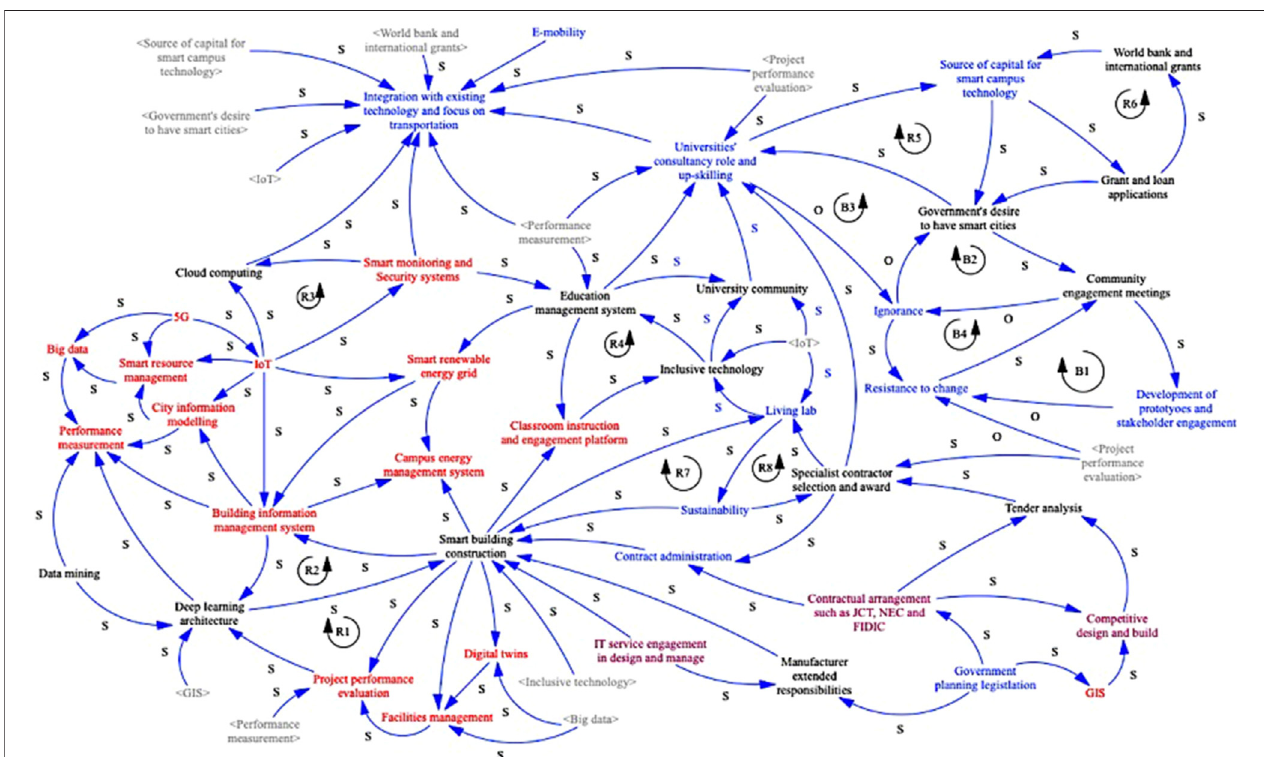
FIGURE 5 | Validated smart campus to cities causal loop diagram (Legend: Red variables (cid:1) smart campus infrastructure; Purple variables (cid:1) smart campus procurement, contracting and construction; Blue variables (cid:1) opportunities and challenges for micro-transferring smart campus infrastructures and knowledge to cities; In black (cid:1) new variables that emerged from the causal loop; S (cid:1) Positive; O (cid:1) Negative; R (cid:1) Reinforcing loop; B (cid:1) Balancing loop). Source: Authors.